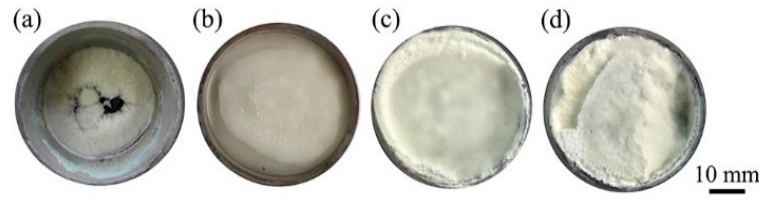
Figure 1. Digital image of the as-achieved products: ( a ) 1100 °C; ( b ) 1200 °C; ( c ) 1300 °C; ( d ) 1400 °C.